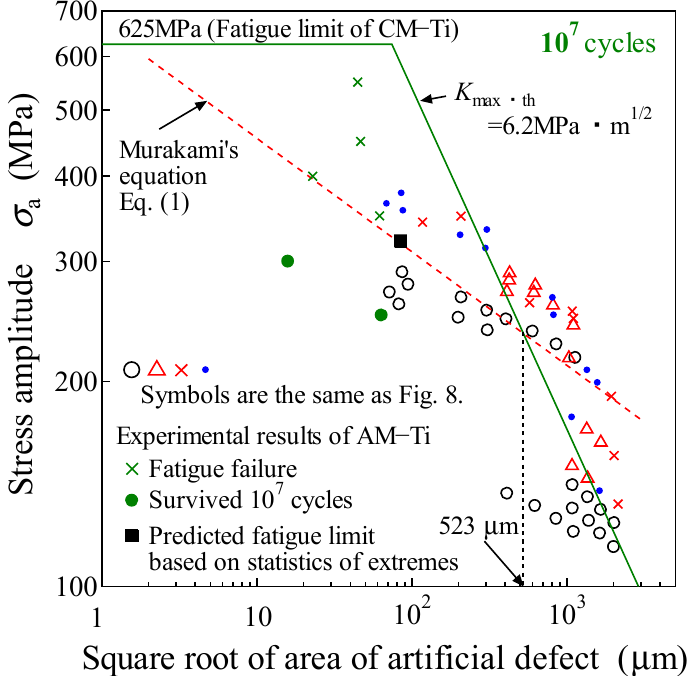
Figure 11. Kitagawa–Takahashi-Murakami diagram at 10 7 cycles.